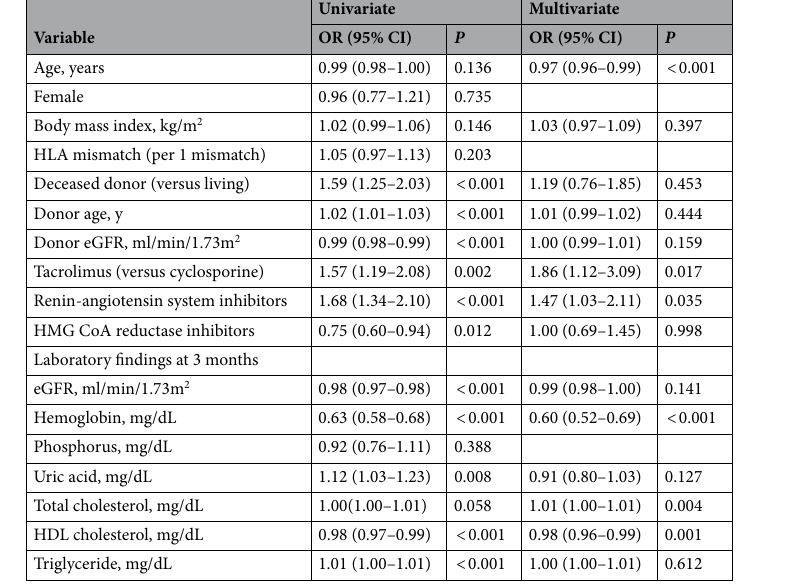
Table 3. Risk factors associated with the lowest serum bilirubin